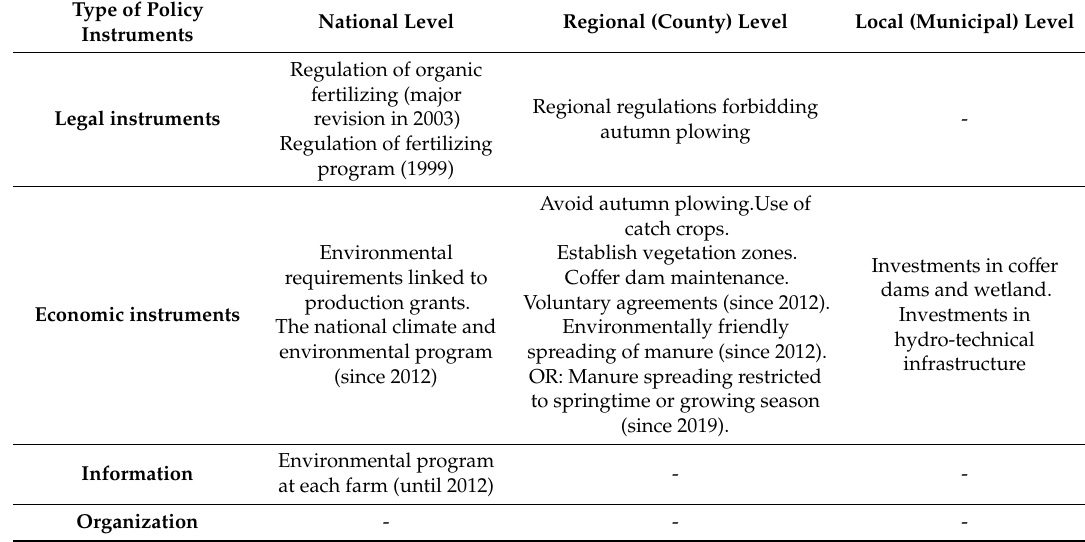
Table 2. List of policy instruments addressing di ff use water pollution from agricultural fields, categorized after type of instrument and level of